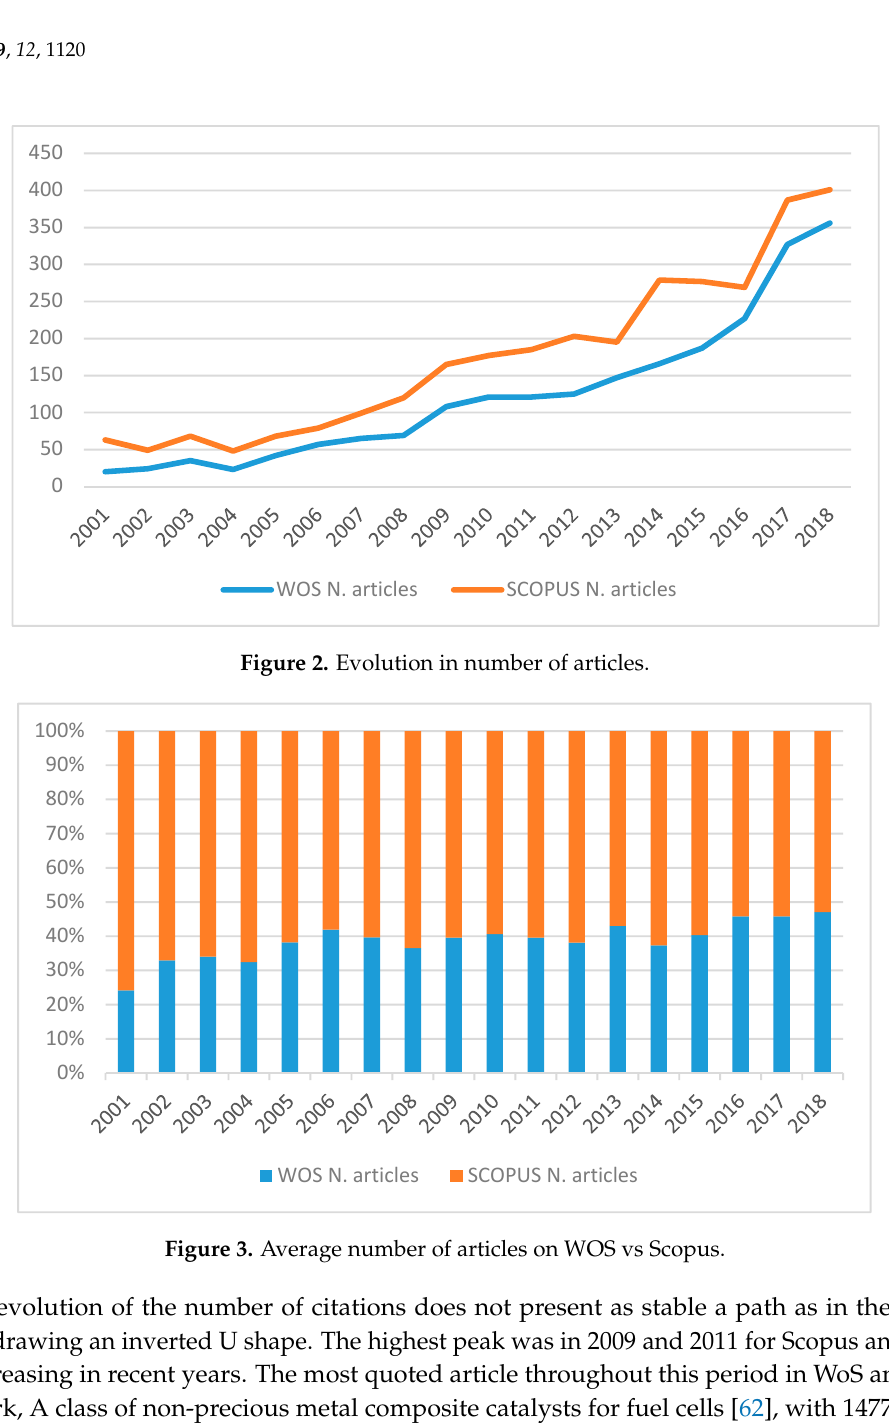
Figure 4. Evolution of total cites.